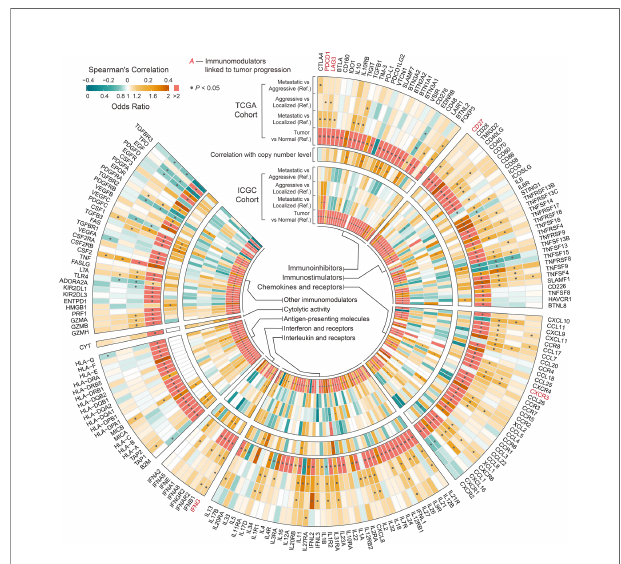
FIGURE 6 | Circular plot showing the differences in immunomodulators among phenotypes and between tumor and normal tissue of ccRCC. Outer circle indicates the differences in immunomodulators among phenotypes and between tumor and normal tissue of ccRCC in TCGA cohort derived from univariable binary logistic regression. Middle circle indicates the correlation between the expression of immunomodulators and the corresponding SCNAs derived from Spearman ’ s analysis. Inner circle indicates the differences in immunomodulators among phenotypes and between tumor and normal tissue